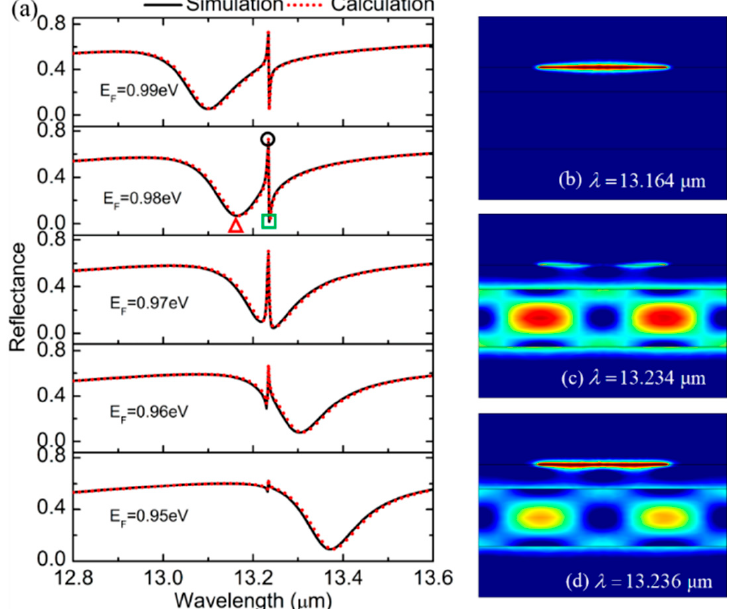
Figure 4. ( a ) Numerical simulation and theoretical calculation of reflectance spectra of the proposed structure when E F = 0.95, 0.96, 0.97, 0.98 and 0.99 eV. ( b – d ) The electric field distribution at the wavelengths marked by ‘ △ ’, ‘ ○ ’ and ‘ □ ’ in Figure 4a.